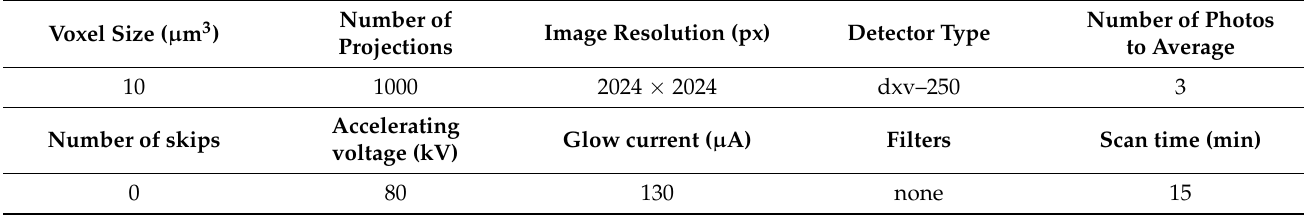
Table 2. Parameters of the microtomographic examination.